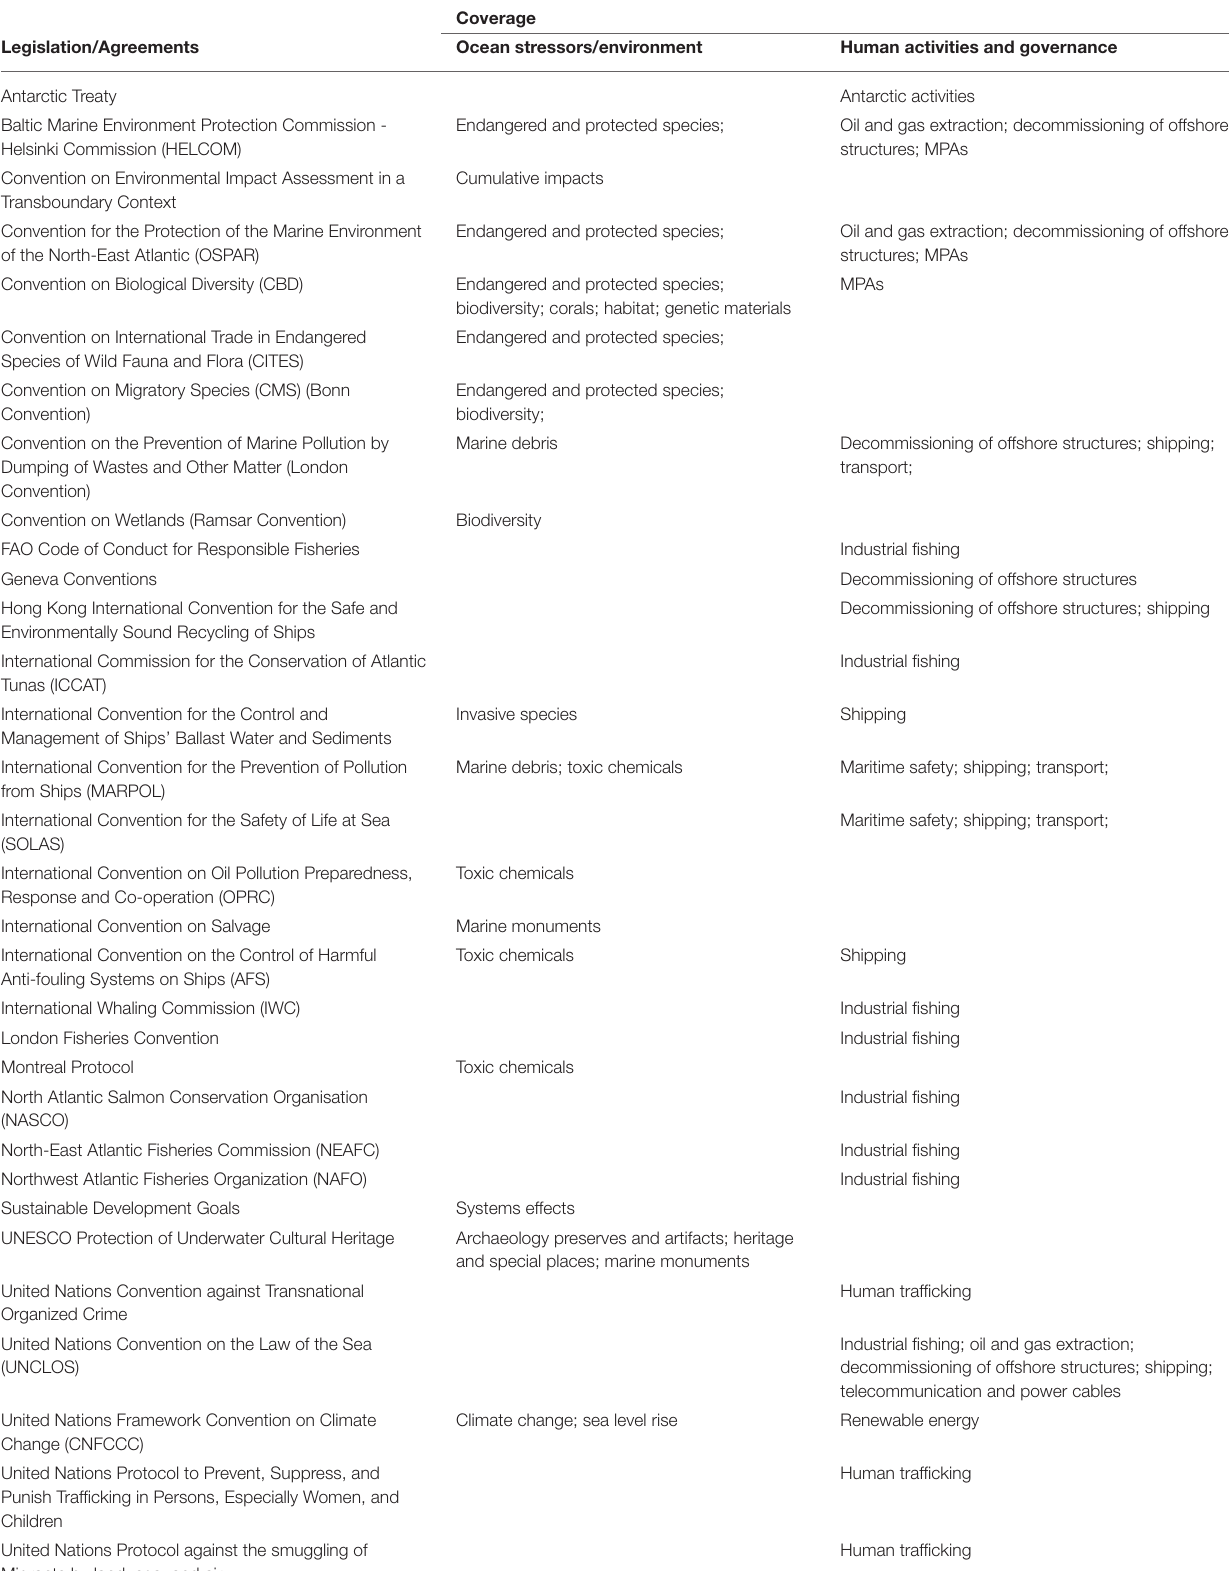
TABLE 5 | International agreements potentially relevant for